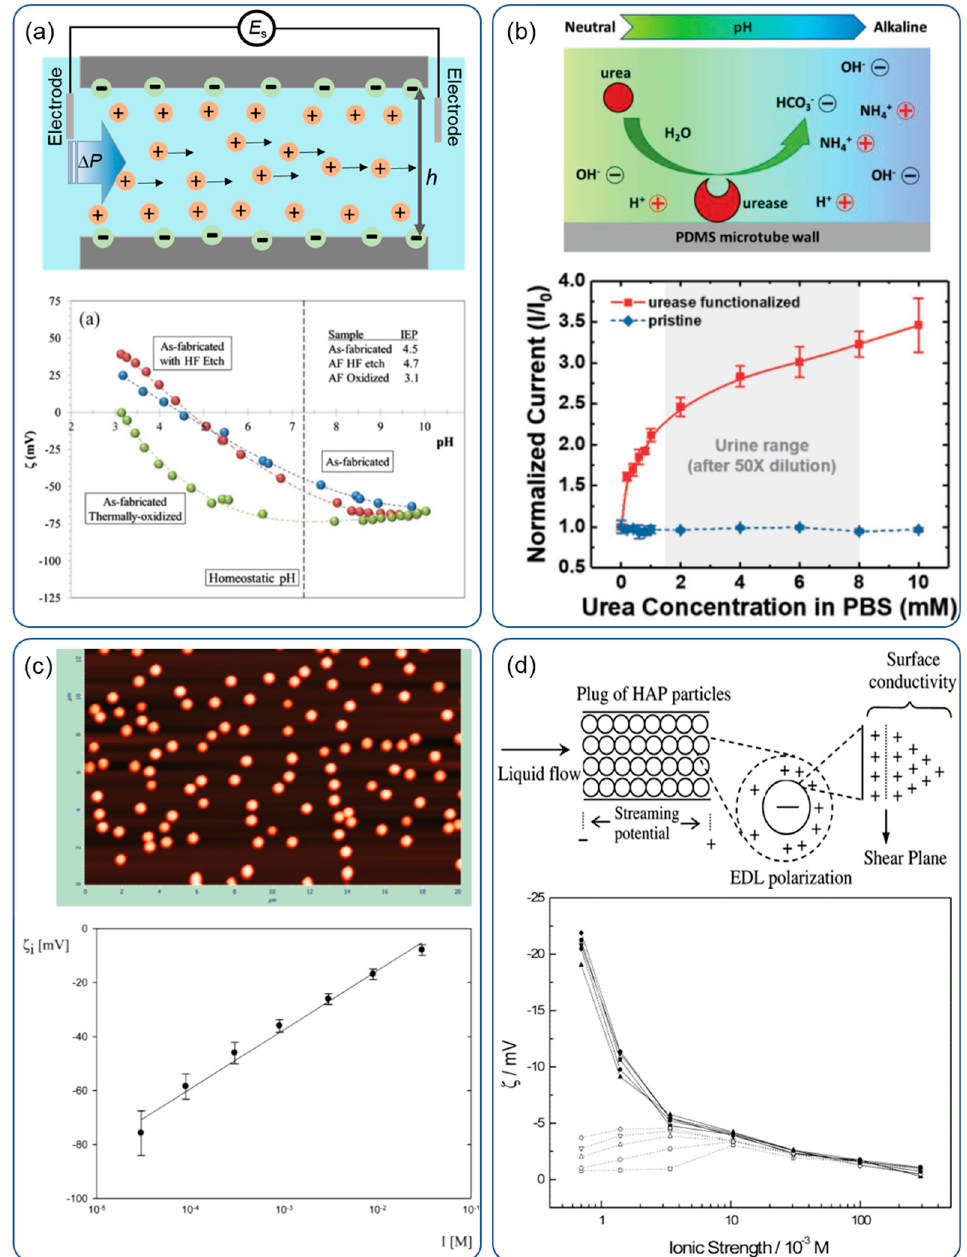
Figure 5. Streaming potential/current measurement for different applications. ( a ) A schematic setup (top) and characterization of surface treatment to silicon nitride surface (bottom)[109]; ( b ) schematic of urea hydrolysis catalyzed by the urease immobilized on microtube wall (top), and current output increases with increasing urea concentration from 0.0–10.0 mM (red line). The current output is independent of urea concentration without urea (blue line) [114]; ( c ) AFM (scan width 20 μ m) of latex particle monolayers on mica (top), and the zeta potential at different MgCl 2 concentration (bottom) [113]; ( d ) schematic diagram of a plug for detecting hydroxyapatite particles with flow potential (top), and relationship between the zeta potential and KCl ion concentrations (bottom) [115].